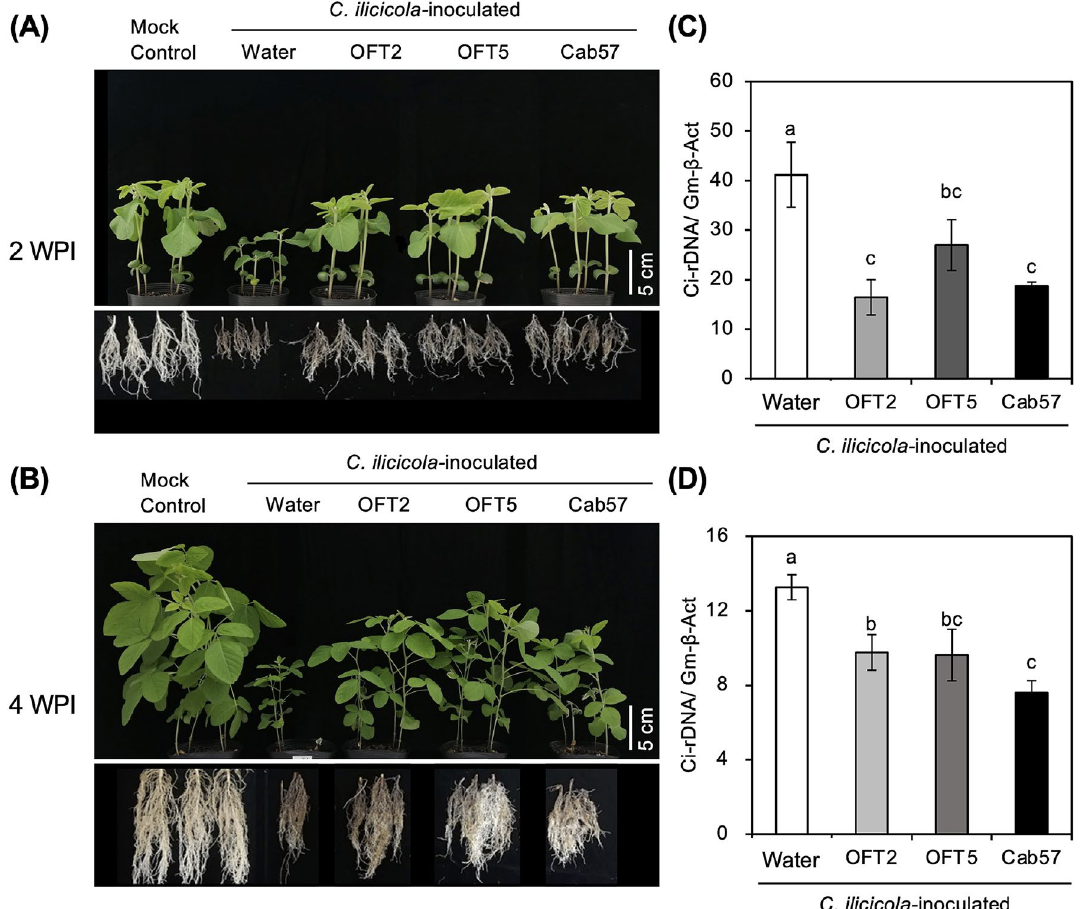
Figure 3. Plant growth features of soybean seedlings ( A ) 2 and ( B ) 4 weeks post-inoculation (WPI) with C. ilicicola (UH2-1), and the relative fungal growth (Ci-rDNA/Gm-b-Act) in the roots at ( C ) 2-WPI and ( D ) 4-WPI (n = 20). Different letters next to error bars indicate that the means are significantly different from each other as per Tukey’s HSD test (p <